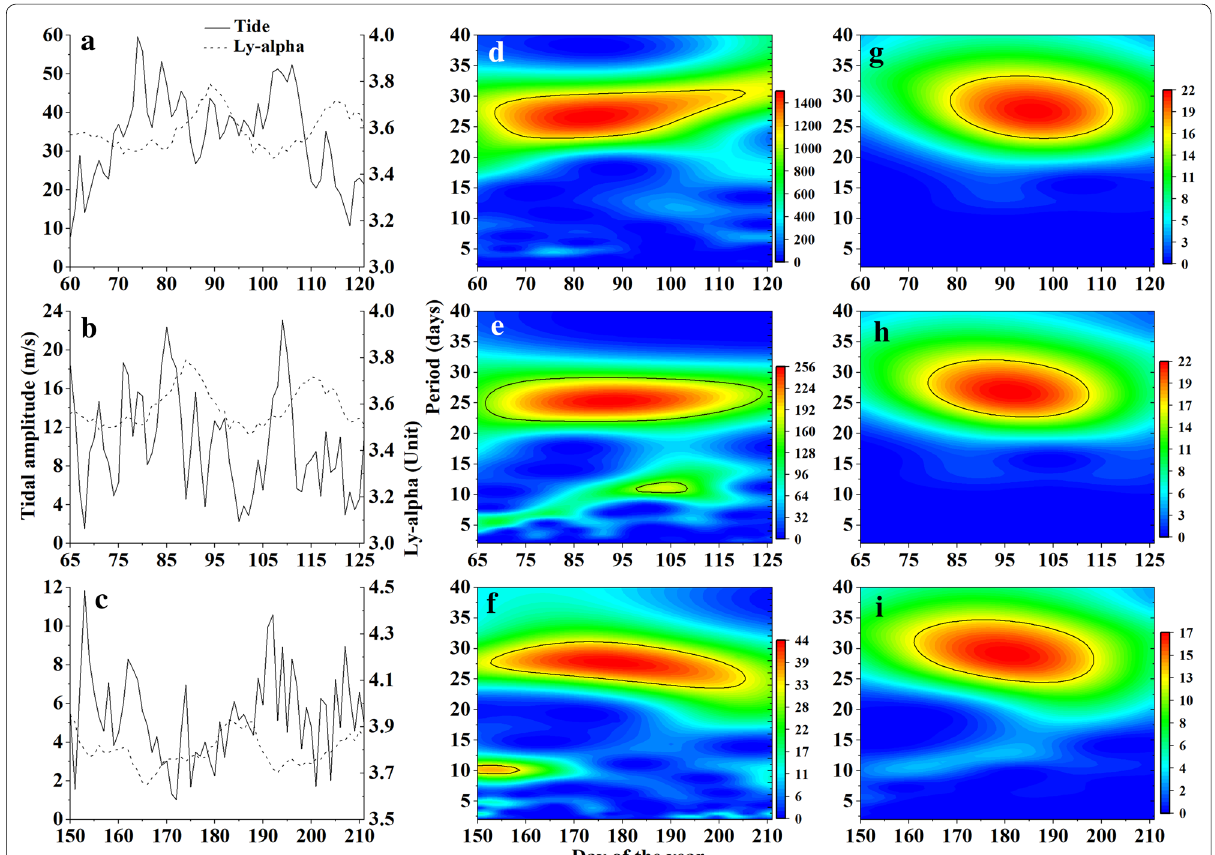
Fig. 1 Daily tidal amplitudes and Ly- α flux (unit 10 11 photons/cm 2 /s) at 90 km for ( a ) diurnal tide during 060–121 DY, 2008 at CP, ( b ) semidiurnal = tide during 065–126 DY, 2008 at CA and ( c ) terdiurnal tide during 150–211 DY, 2006 at SM. Corresponding wavelet spectra estimated from the daily amplitude in the zonal wind for ( d ) diurnal tide, ( e ) semidiurnal tide and ( f ) terdiurnal tide. Wavelet spectra computed from the daily Ly- α data shown in plots g , h and i corresponding to the intervals of a , b and c ,